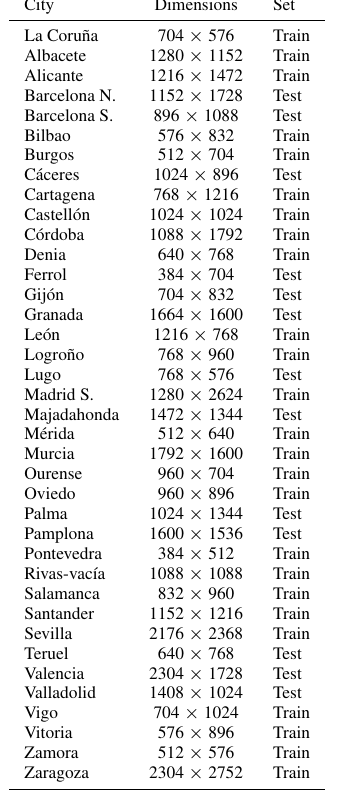
Table 2. Summary of the dataset. Overall, the training set is composed of 25 zones ( ≈ 66%) whereas the test set consists of 13 zones ( ≈ 34%).